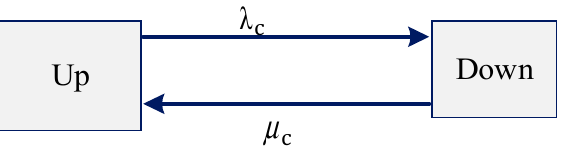
Figure 6. Two-state model for power converter. Table 3. Failure rate for power converter components [31,33].